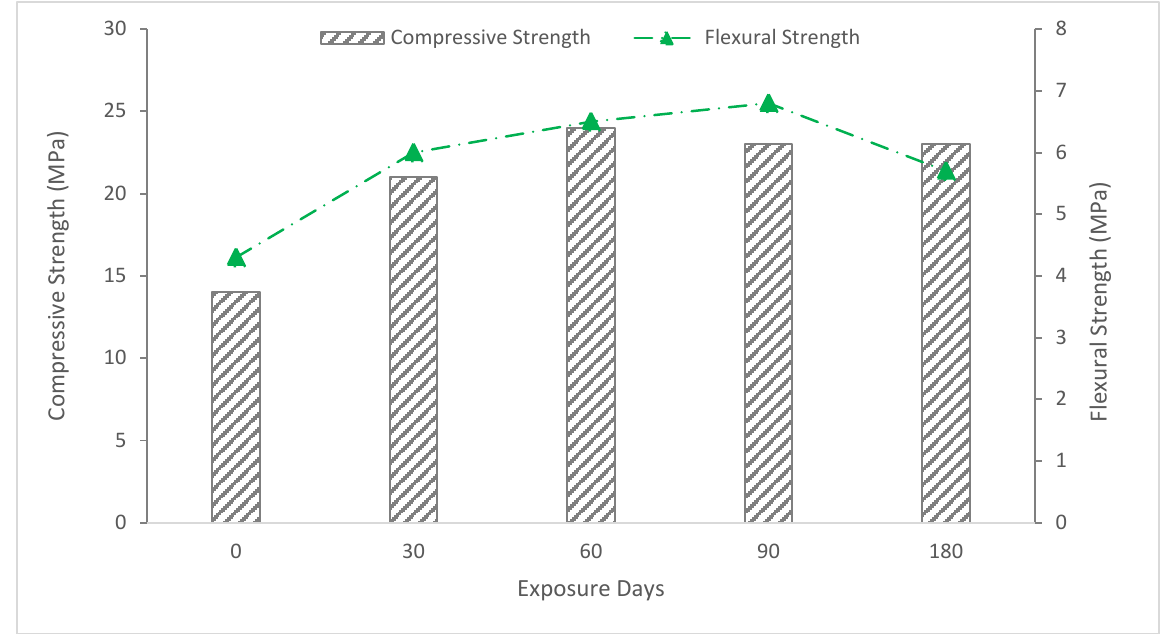
Figure 14. Strength of dune sand mortars immersed in sodium sulfate solution (5%) at 180 days [73].